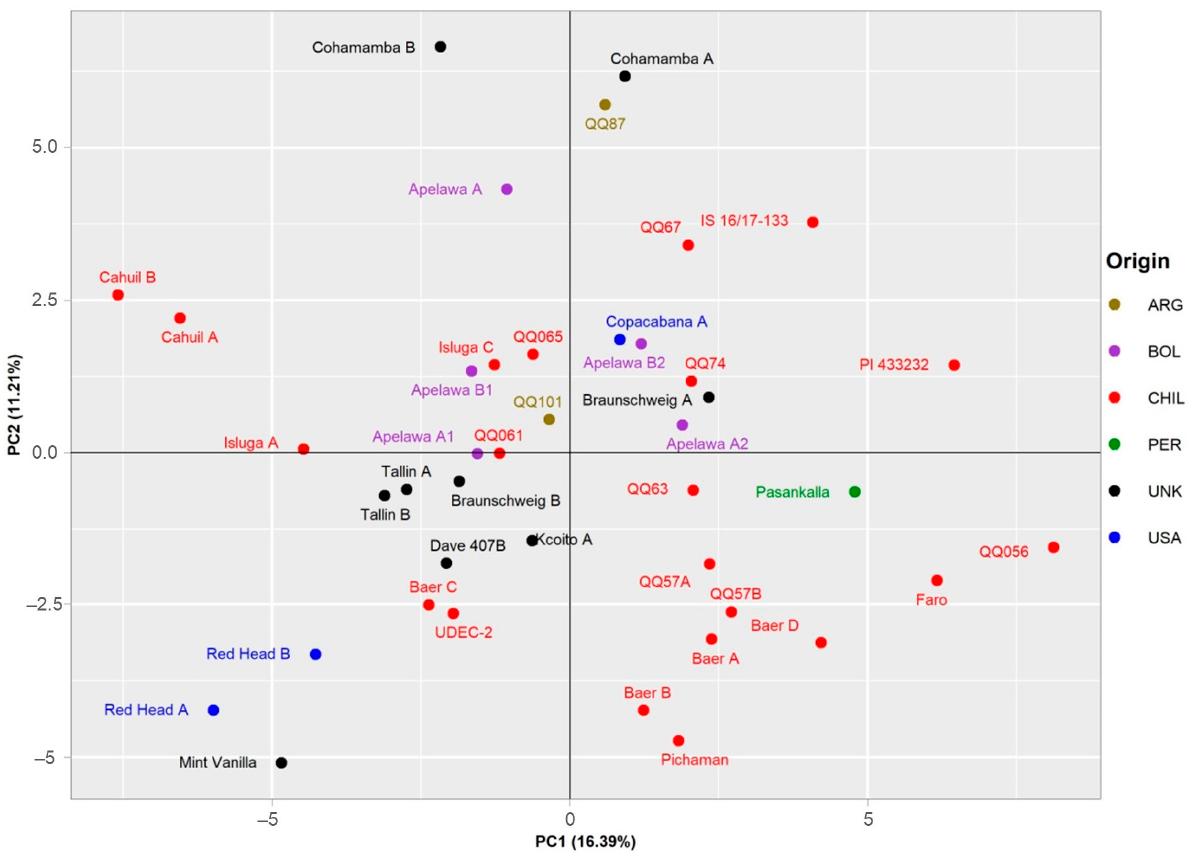
Figure 6. Principal component analysis based on set of 19 descriptors for the set of 41 genotypes. Two main components explaining 16.39% and 11.21% of the total variability, respectively, are displayed. Individual accessions are labeled according to the country of origin, as illustrated in the legend on the right side of the plot.